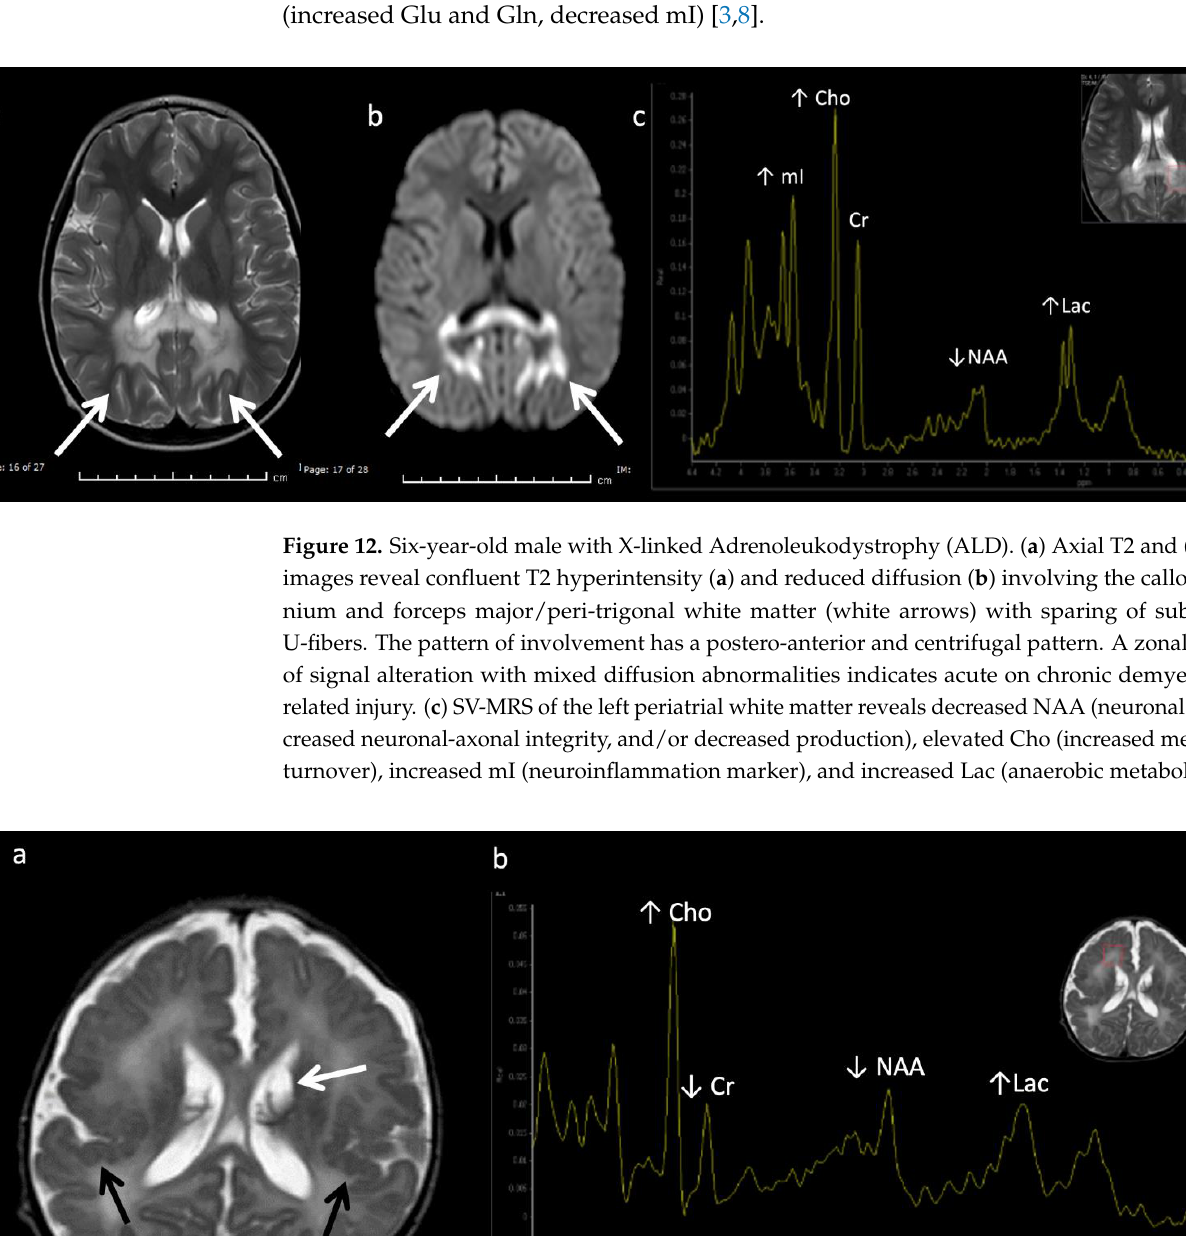
Figure 14. Canavan disease in a 4-month-old infant who presented with hypotonia, spasticity, and elevated urine organic acids. ( a ) Axial T2WI reveals diffuse white matter hyperintensity involving the subcortical U fibers throughout, the globi pallidi, and thalami with sparing of the striatum. ( b ) SV-MRS of the left parietal white matter shows severely elevated NAA (210 – 240% above normal) due to lack of enzyme degradation. MI is also elevated, and Cho and Cr are low.